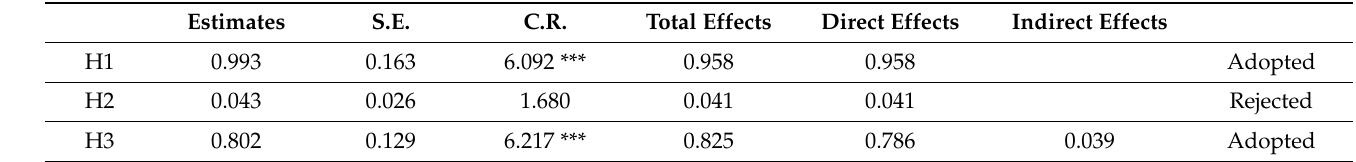
Table 5. Path coefficient of mediated